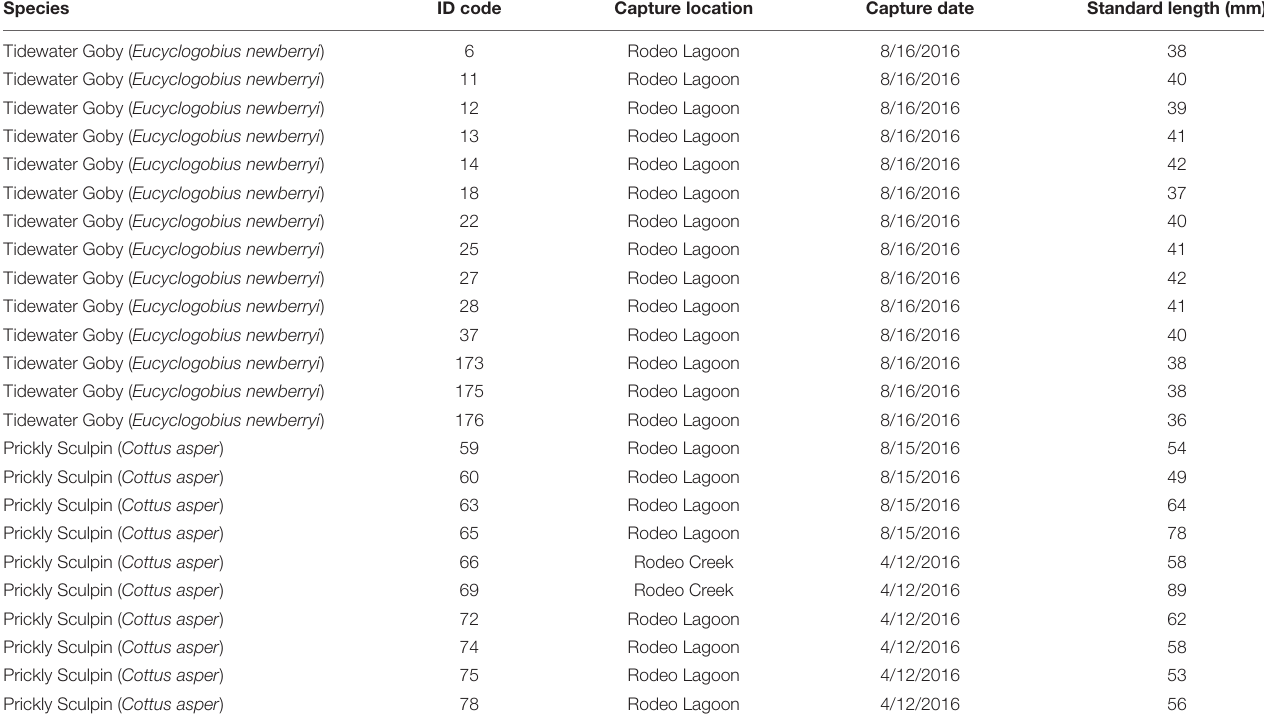
TABLE 1 | Sources of otoliths examined in this study.